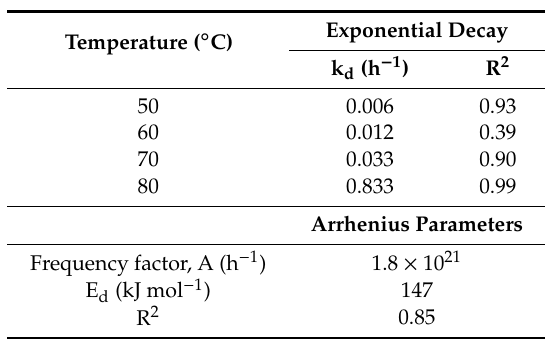
Table 4. Exponential decay and Arrhenius parameters for β -mannanase deactivation.